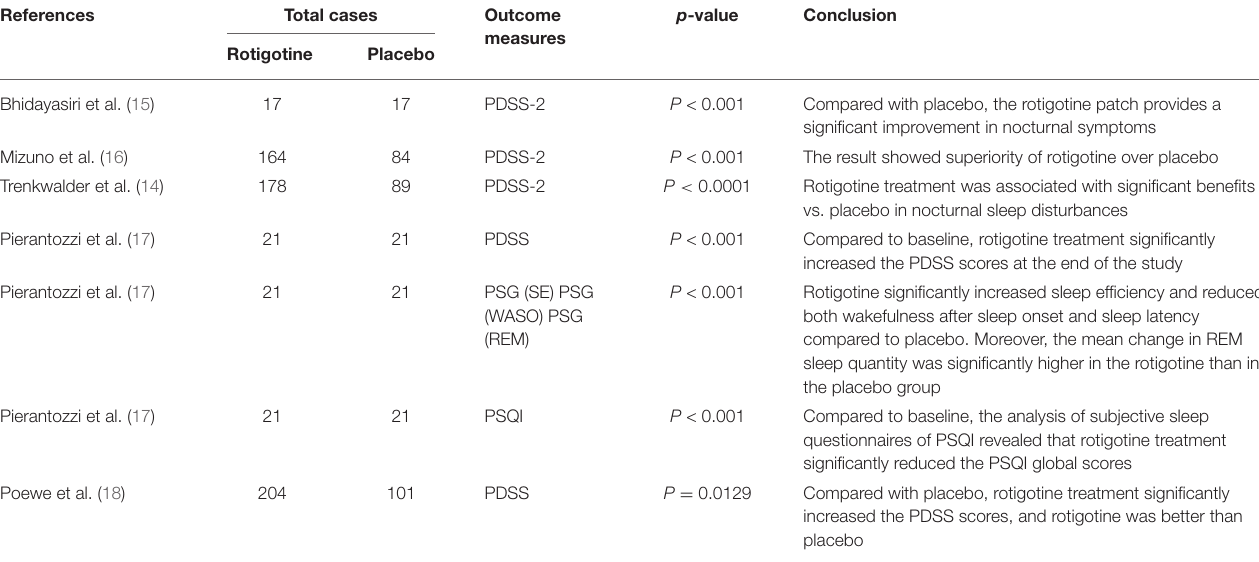
TABLE 2 | Effect of rotigotine vs. placebo on sleep in patients with Parkinson’s